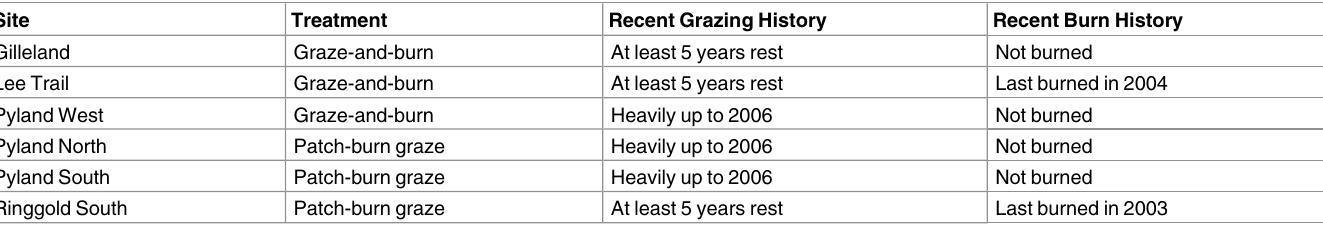
Table 2. Recent land use history of cattle pastures. Recent history is up to five years prior to